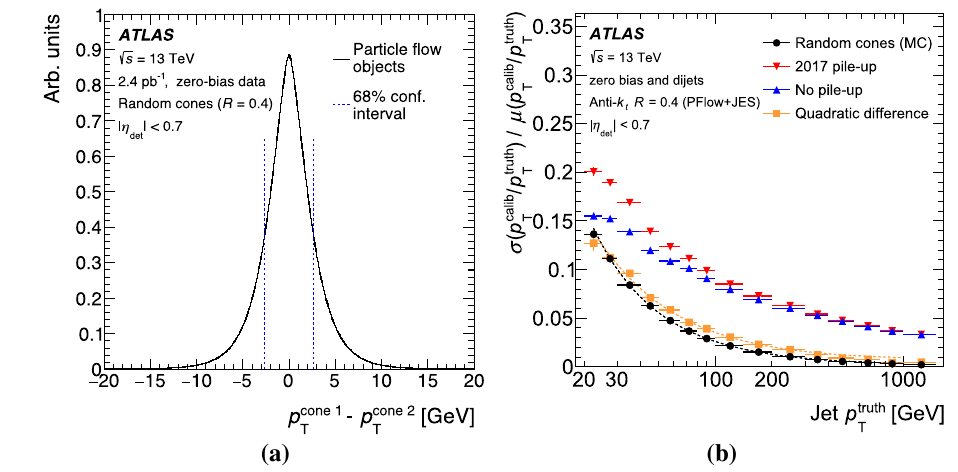
Fig. 27 a The difference inthe random cone sums, (cid:7) p RC , measuredin fromMCsimulation(orangesquares)asextractedfromthedifferencein T the central region ( | η det | < 0 . 7) in randomly triggered data using PFlow quadratureofMCsimulationwith(reddownwardtriangles)andwithout objects. b Comparison between the pile-up noise term N PU determined (blue upward triangles) pile-up. Results are shown at the PFlow+JES using the random cone method (black solid circles) and the expectation energy scale for jets in the central region of the detector ( | η det | < 0 . 7)